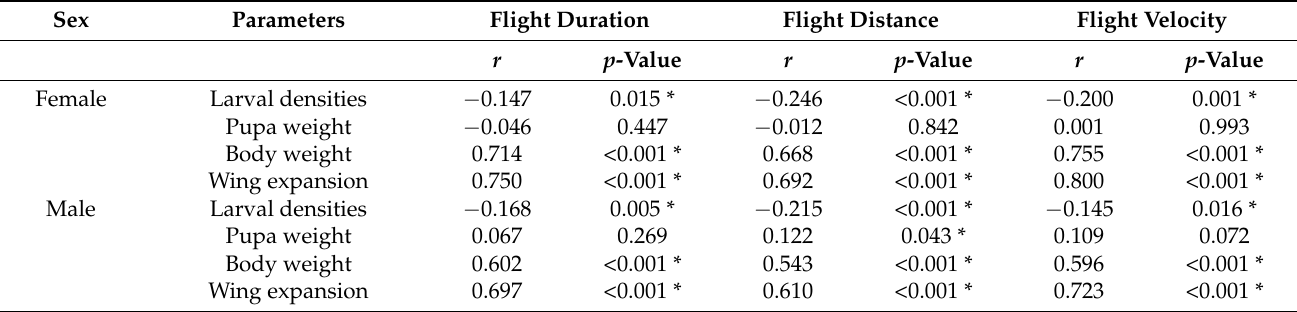
Table 3. Pearson correlations of flight distance, flight velocity, and flight duration of Spodoptera frugiperda adults under different larval densities, with pupa weight, body weight and wing